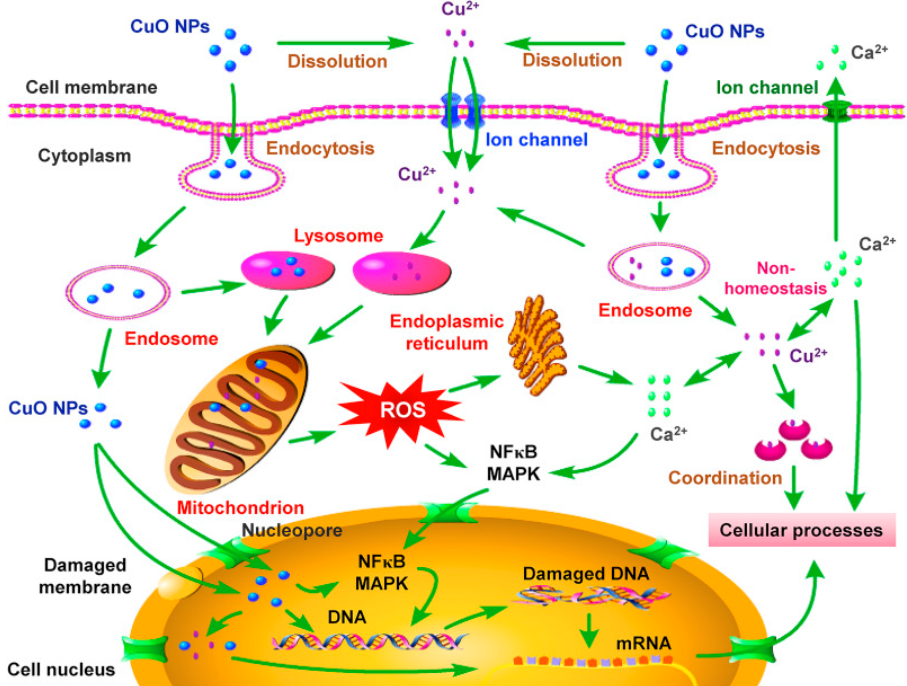
Figure 3. CuO NPs mechanism of action [76].